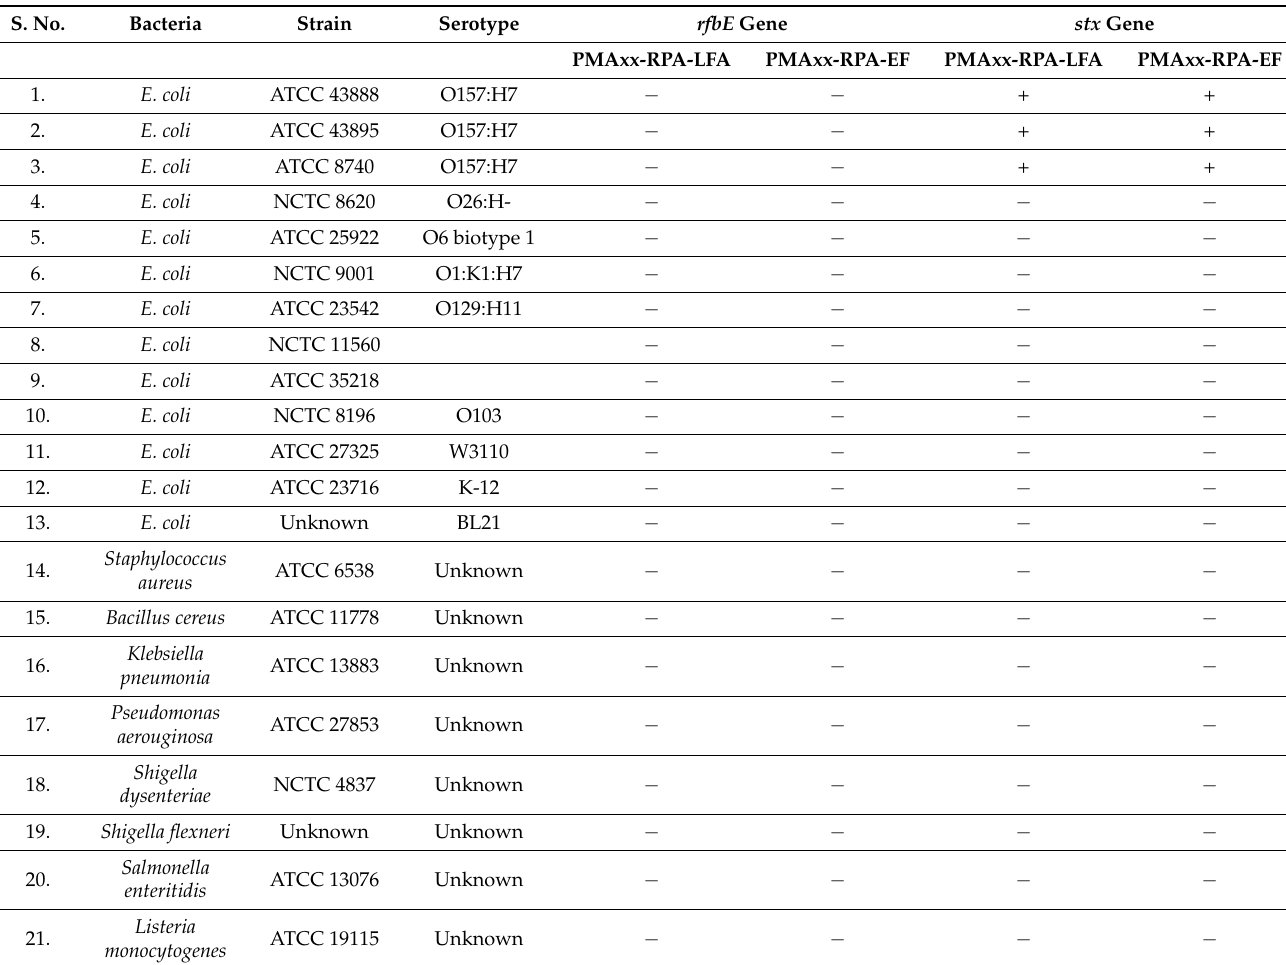
Table 1. Specificity of